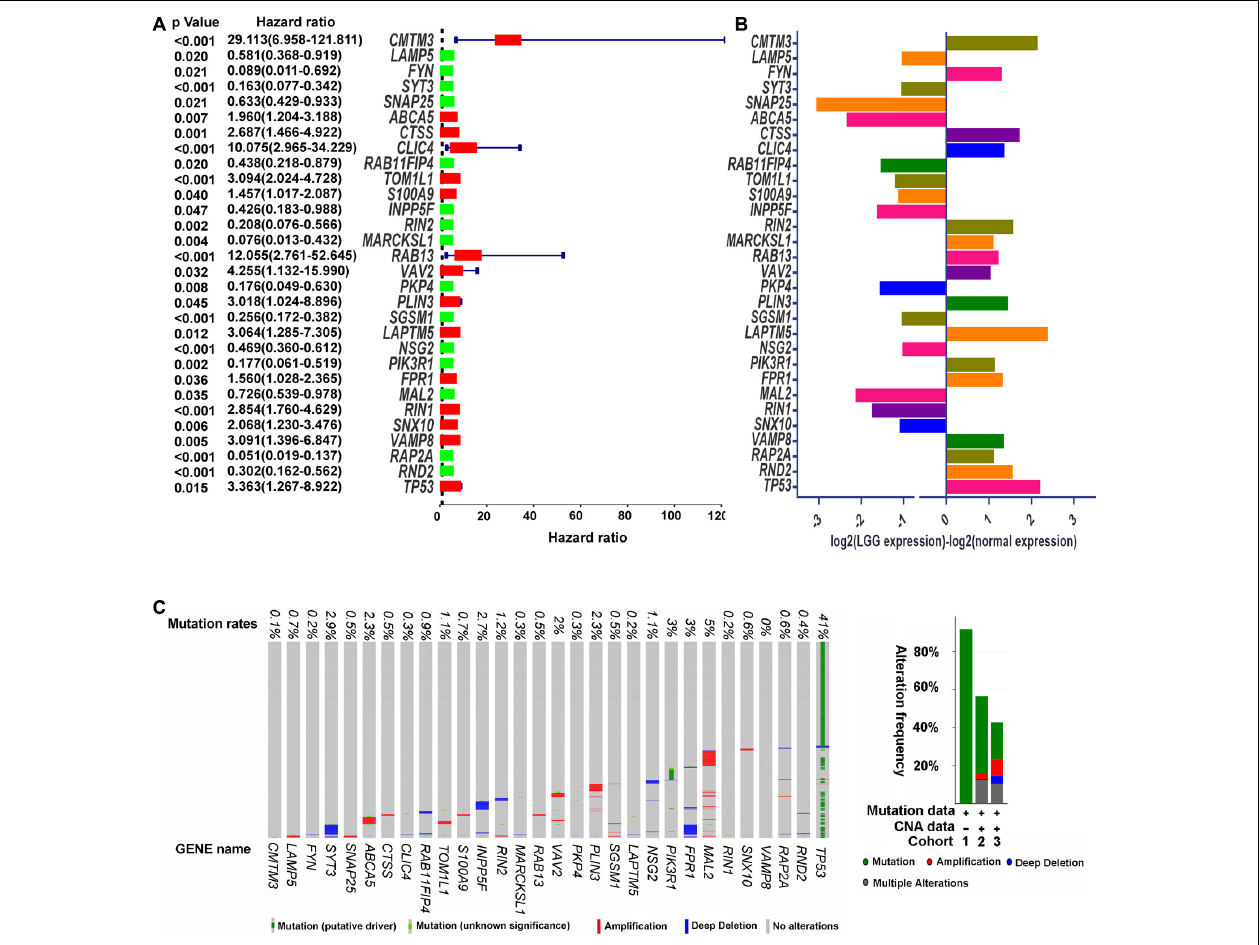
FIGURE 4 | Identification of prognosis-related DEERGs. (A) Univariate Cox proportional hazard regression analysis of DEERGs. (B) Comparison of prognosis-related DEERGs mRNA expression between normal brain tissues and TCGA-LGG tissues. (C) Genetic alteration of prognosis-related DEERGs in LGG sample. Cohort 1: Low-Grade Gliomas (Johnson et al., 2014); Cohort 2: Brain Lower Grade Glioma (TCGA, PanCancer Atlas); and Cohort 3: Brain Lower Grade Glioma (TCGA, Firehose Legacy). Hazard ratio estimates the ratio of the hazard rate under two levels of an explanatory variable, such as female VS male. The hazard rate is the probability of an event occurring per unit of